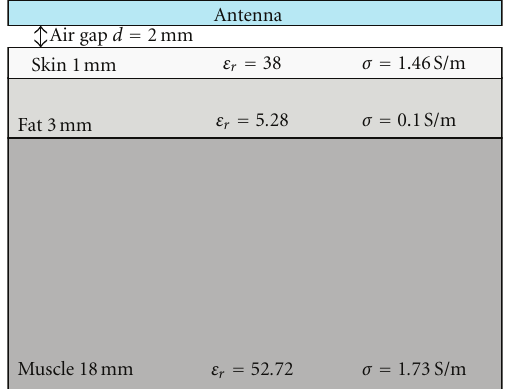
Figure 16: The textile array is placed on top of the model of a human body used for the simulations [23]. The dielectric values of three di ff erent human tissues, at 2.45 GHz, are those reported in [24–26].